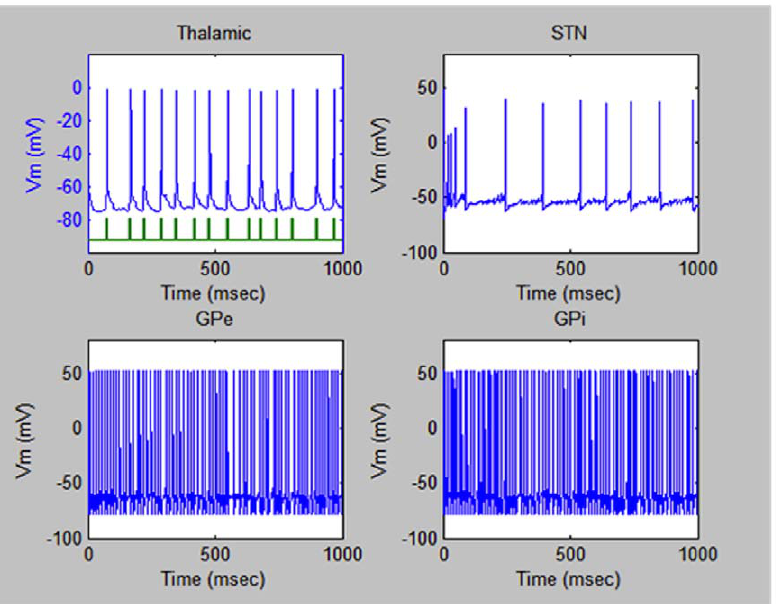
Figure 2. Electric pulses in the brain of a healthy person. Typical electric pulsed sequences triggered in the four regions of the brain under study of a healthy person under normal conditions.